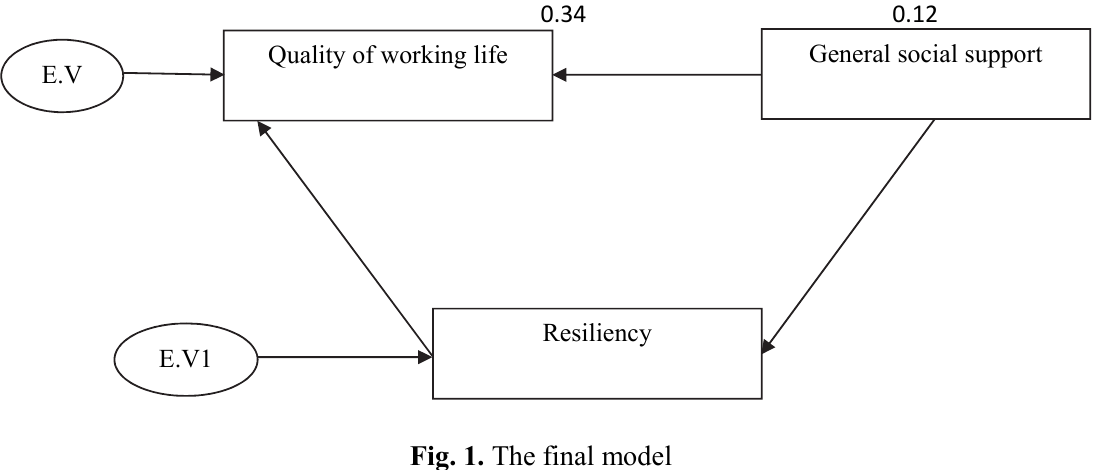
Fig. 1. The final